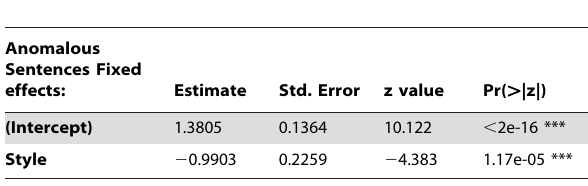
Table 3. Results of the linear mixed effects logistic regression on intelligibility data for anomalous sentences.